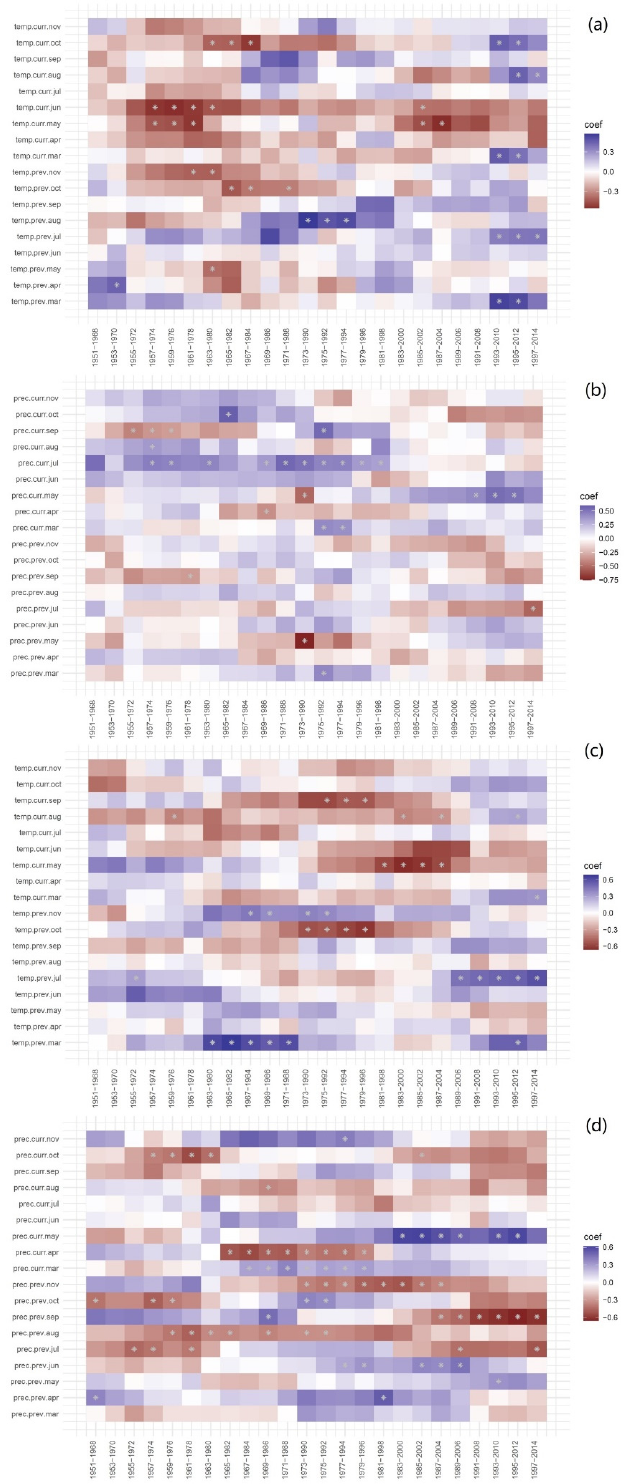
Figure 4. Moving window correlations between the ( a ) TRW chronology of Tajikistan and temper- ature; ( b ) TRW chronology of Tajikistan and precipitation; ( c ) ∆ 13 C chronology of Tajikistan and temperature; ( d ) ∆ 13 C chronology of Tajikistan and precipitation of the previous March to the current November. The moving correlation was conducted in windows of 18 year, offset by 2 a. Blue shading indicates a positive correlation; red shading indicates a negative correlation. The asterisk (*) indicates a statistically significant